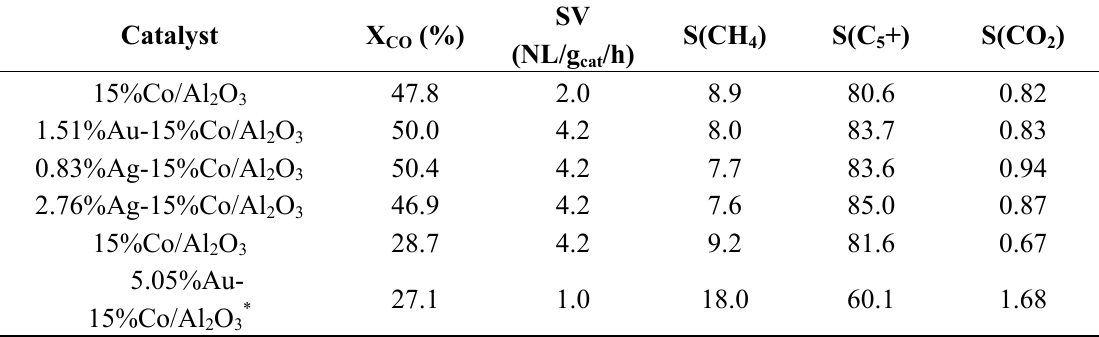
Table 4. Product selectivities for Ag and Au-promoted 15%Co/Al values comparable to the unpromoted catalyst. Conditions: 220 °C, 1.6 MPa, H (adapted with permission from [10] Copyright 2009,